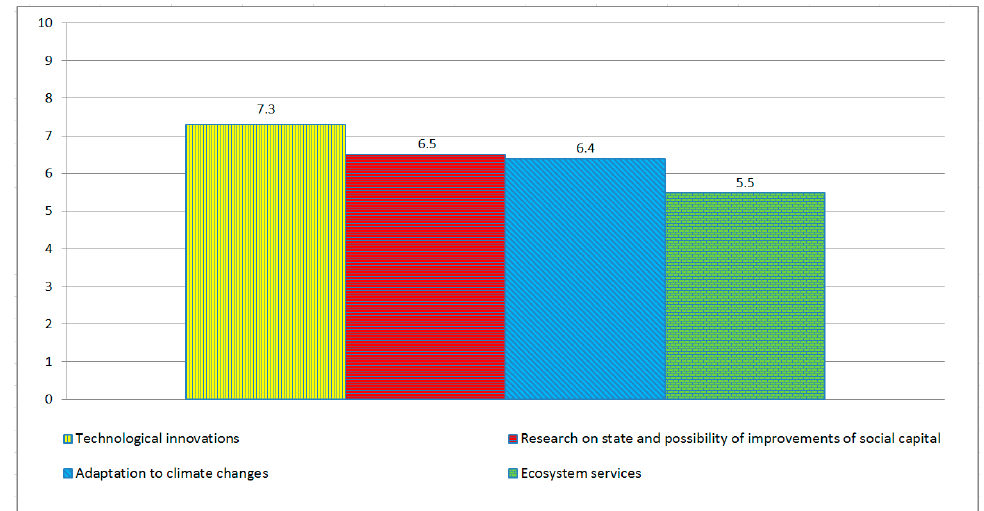
Figure 5. Compatibility of the approach of the Polish CAP Strategic Plan to research and innovation with key research areas identified by the living lab. Source: Study results.